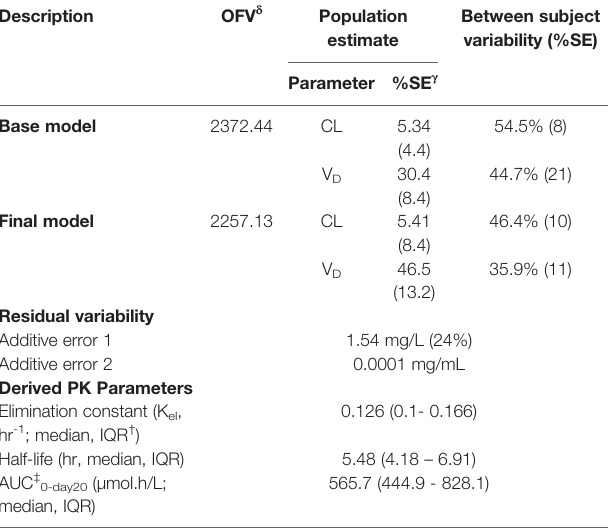
TABLE 3 | Population pharmacokinetic parameter estimates.